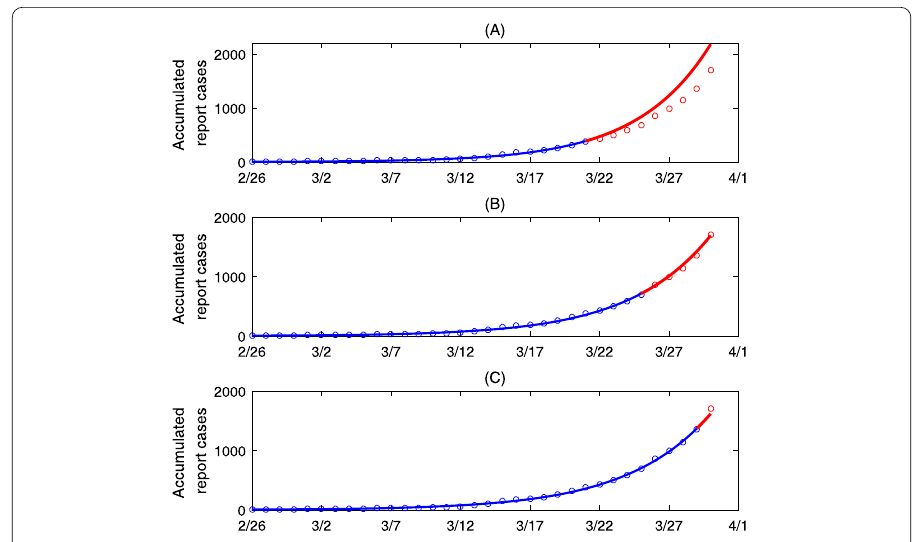
Figure 2 Best model fitting results and model predictions. Here, the blue curves are the best fitting curves while the red curves are the predicted curves from the best fitting model. The circles denote the real data